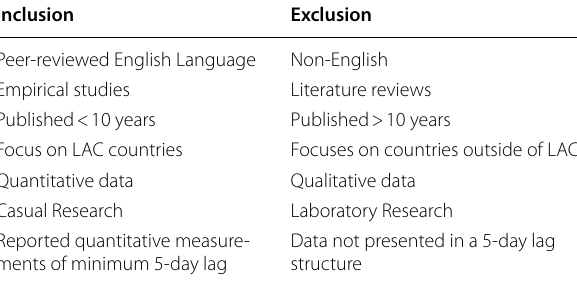
Table 1 Criteria for inclusion and